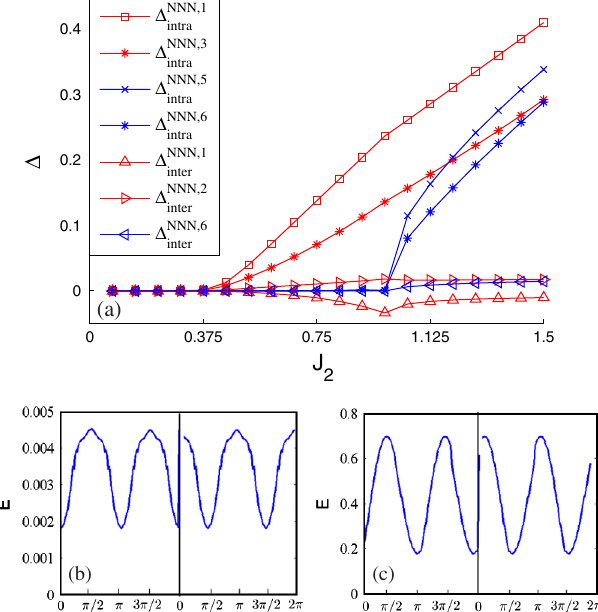
¼ 0 in parameter 1 ¼ 0 : 4 and 2